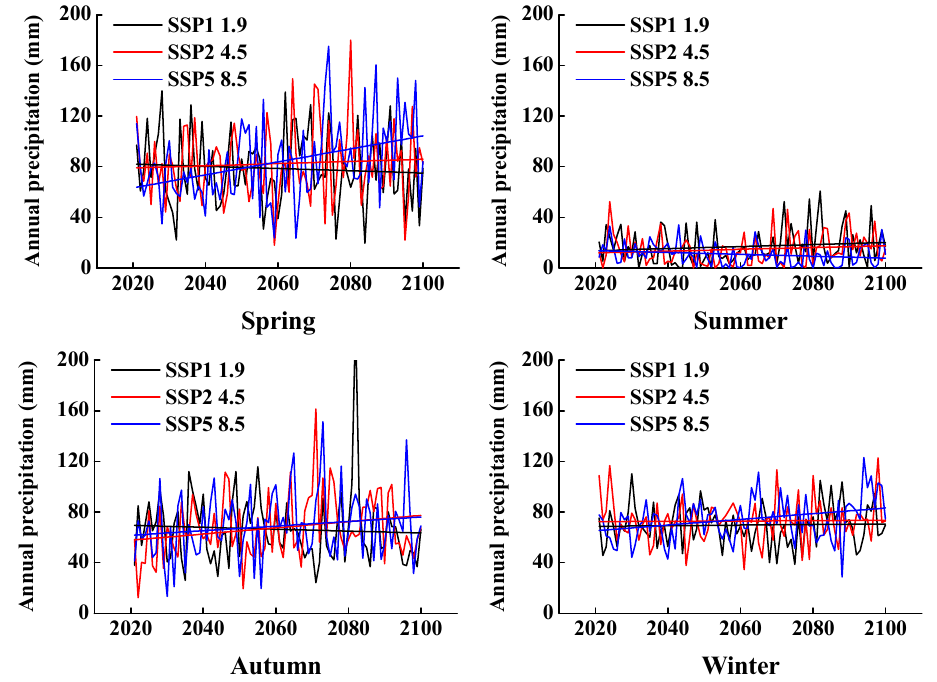
Figure 3. Projected precipitation in spring, summer, autumn, and winter in SSP1 1.9, SSP2 4.5 and SSP5 8.5 scenarios from 2021 to 2099, using data from the Fukang weather station.